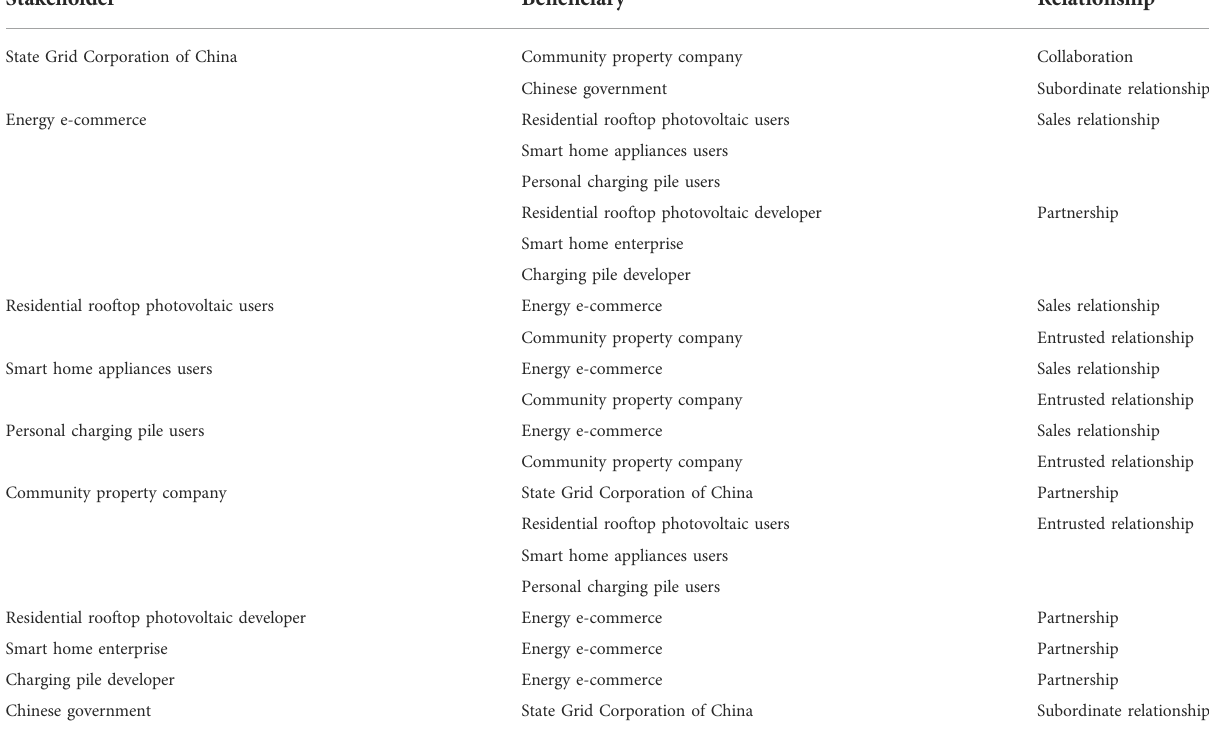
TABLE 2 Relationship between